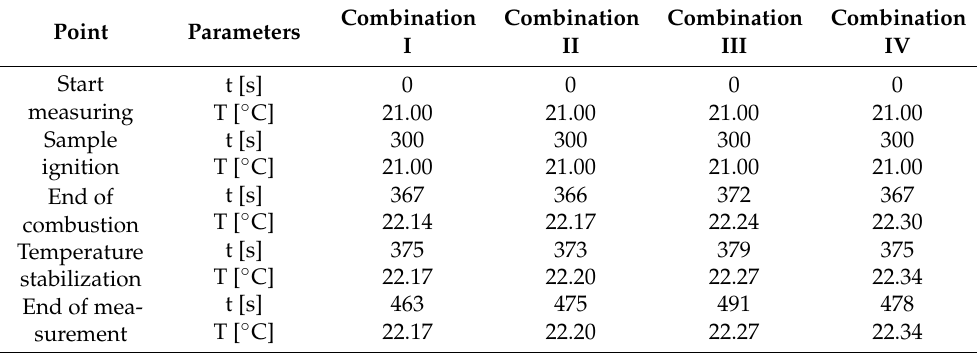
Table 1. Characteristic temperature points of spruce sawdust